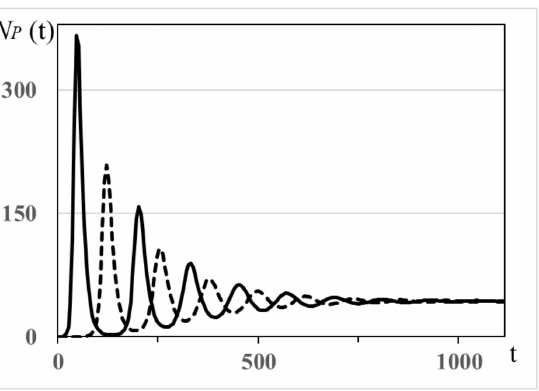
Fig. 8. Graphs of N P ( t ) for oscillating dynamics for 2 different initial values ϕ ( a ) .